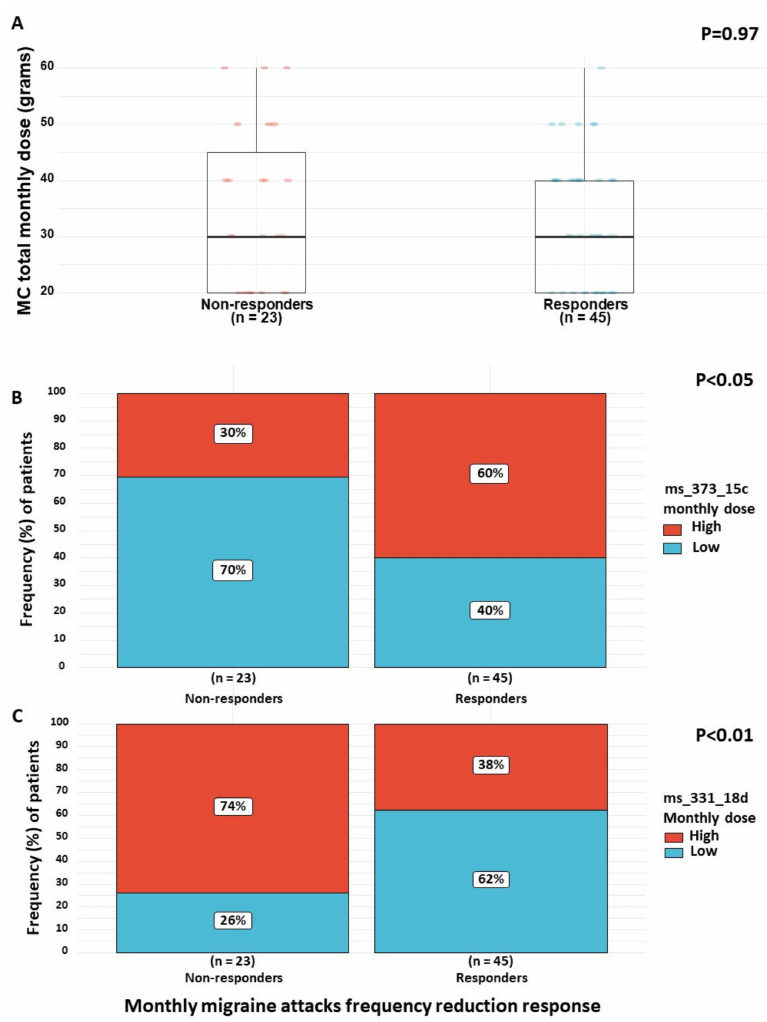
Figure 3. ( A – C ) Phytocannabinoid dose di ff erences between responders and non-responders.